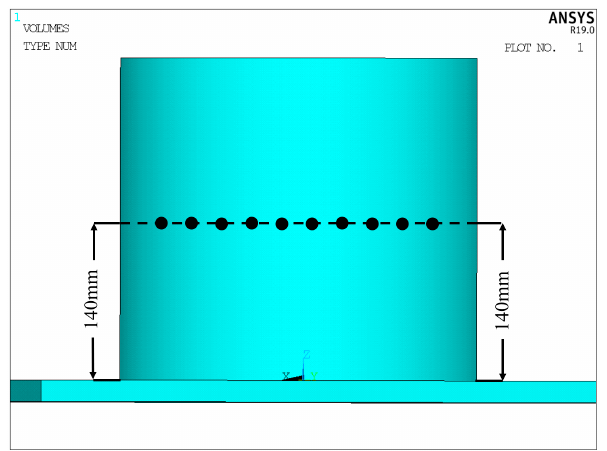
Figure 9. Schematic diagram of node selection of vertical plate along the welding direction.